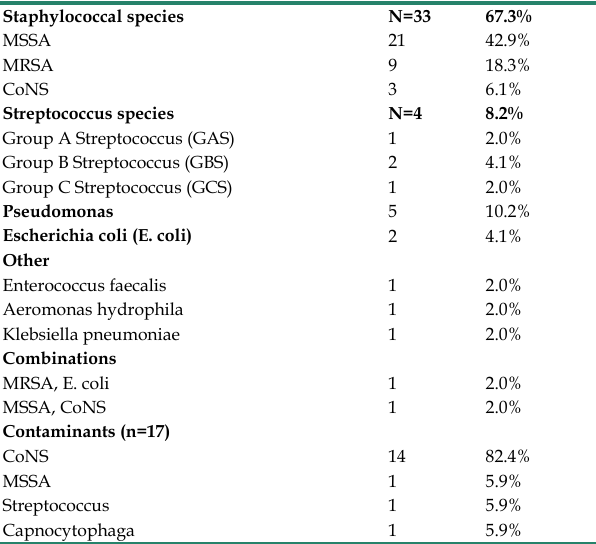
Table 2. Microbiology results of the 49 cases of septic